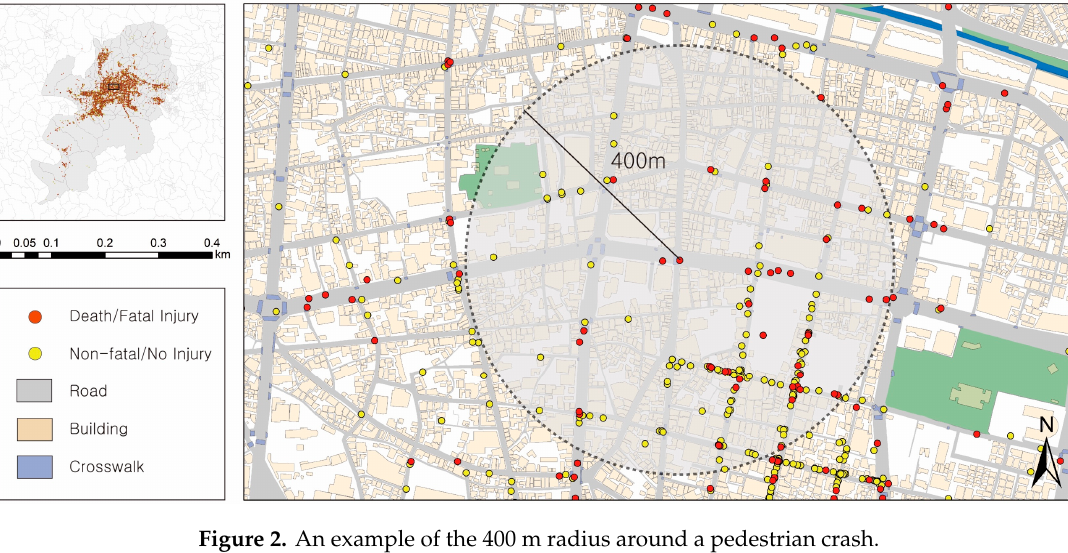
Figure 2. An example of the 400 m radius around a pedestrian crash.